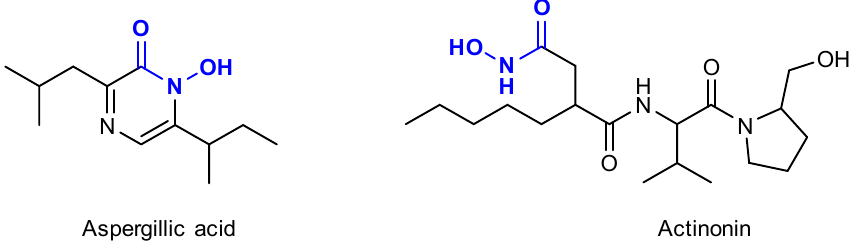
Figure 1. Natural occurring hydroxamic acids aspergillic acid and actinonin.